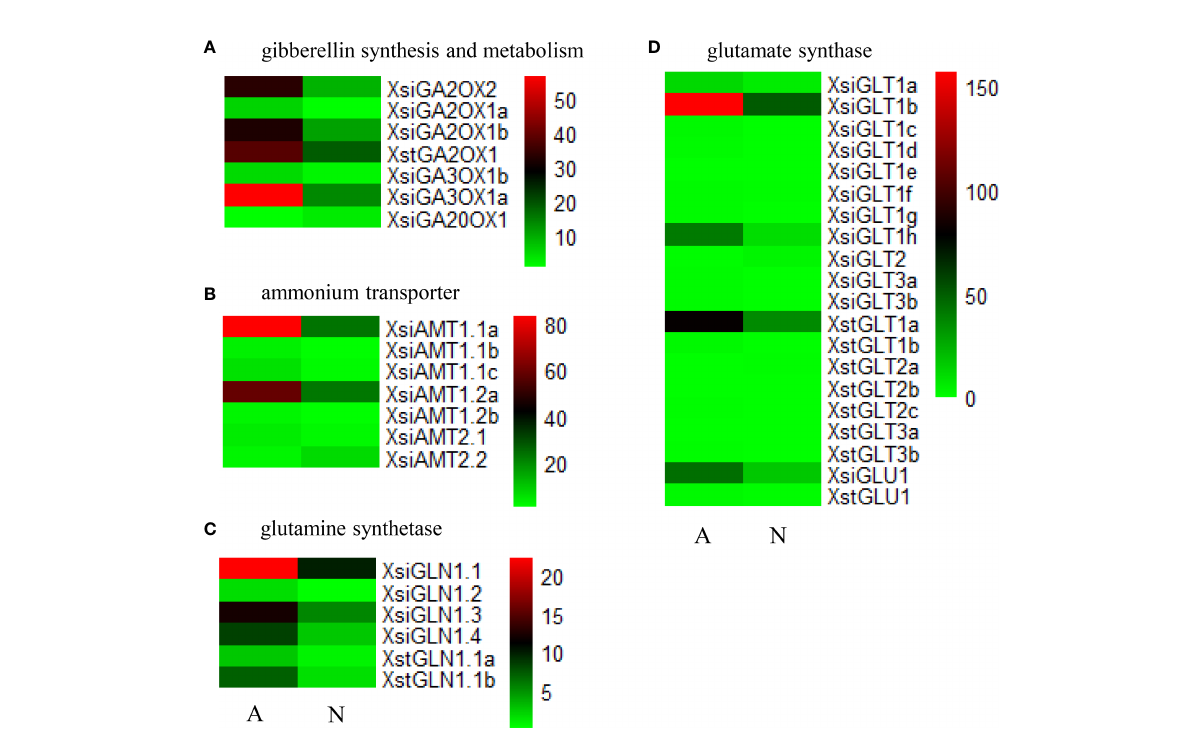
FIGURE 4 Expression patterns of the differently expressed transcripts (DETs) related with gibberellin synthesis and metabolism (A) , ammonium transporter (B) , glutamine synthetase (C) and glutamate synthase (D) in Xanthium sibiricum and X. strumarium . For X. strumarium , there were no DETs related with ammonium transporter. Different colors represent different expression levels (increasing from green to red). A and N indicate ammonium and nitrate treatments, respectively. The names of the transcripts were gased on our phylogenetic analyses (Figures